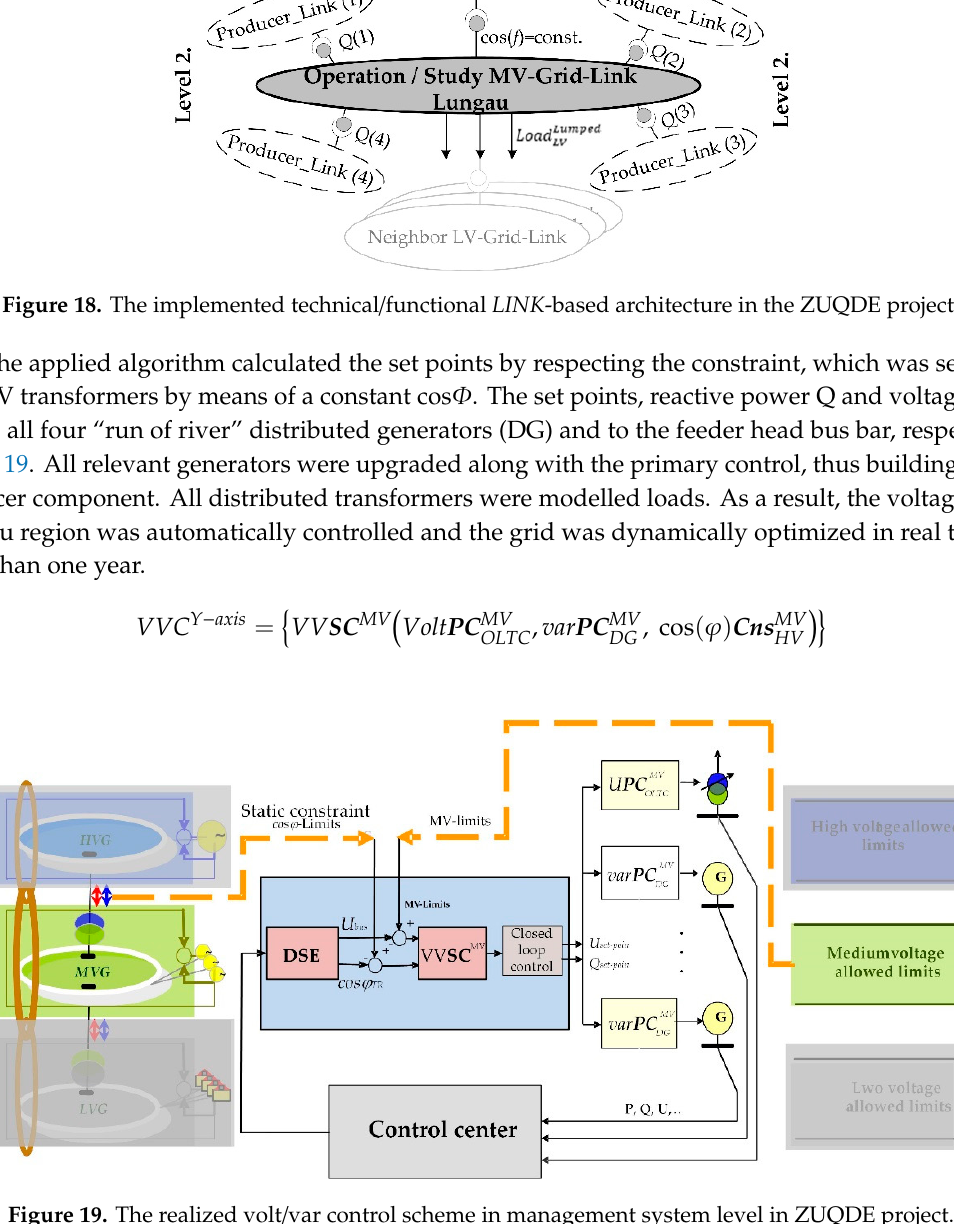
Figure 19. The realized volt/var control scheme in management system level in ZUQDE project.